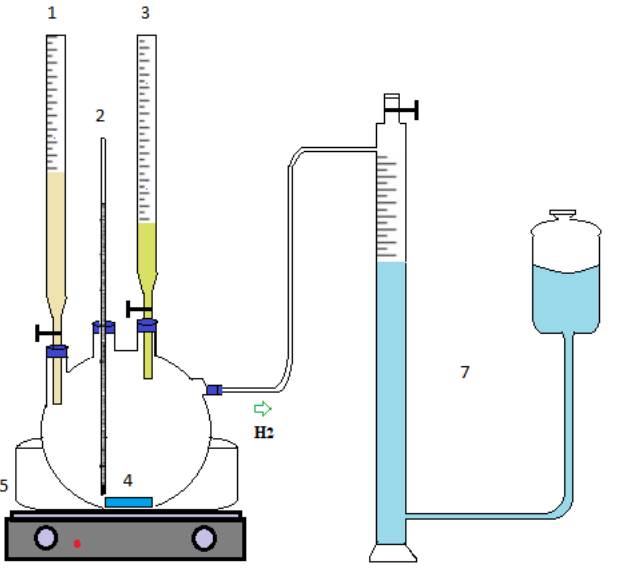
Figure 1. Schematic representation of the experimental setup: (1) alkaline KBH 4 solution feeding, (2) thermometer, (3) HCl solution feeding, (4) catalyst, (5) water bath, (6) hot plate, (7) gas burette sys- tem.